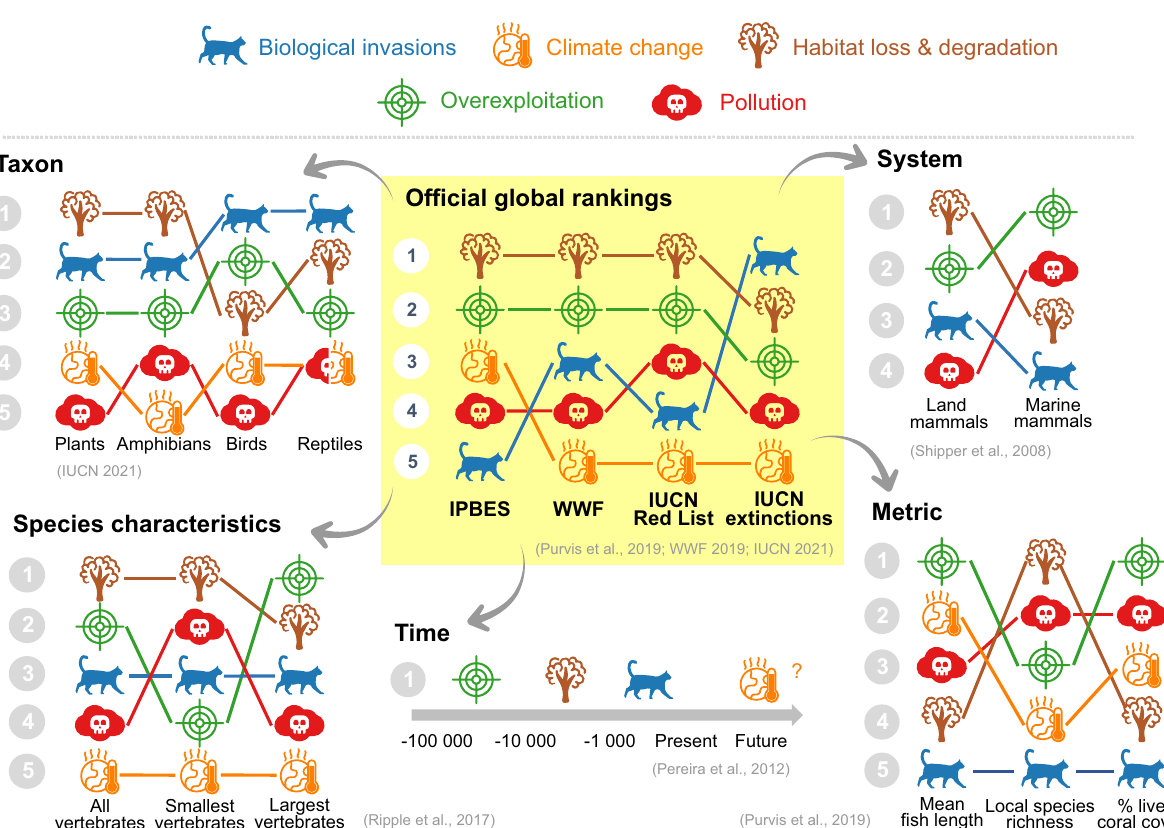
Fig. 1 Divergence of global threat rankings across different references and international agencies. IPBES, WWF, and IUCN established global rankings of the fi ve threats responsible for the current biodiversity crisis (B: central, yellow panel). However, the relative importance of each threat depends on the taxon, system, species ’ characteristics, time, and/or the metric considered, resulting in divergences. Global biodiversity threats are represented by colors and symbols, given in the top panel. This fi gure encapsulates results combined from different studies detailed in Supplementary Table 1 with their associated